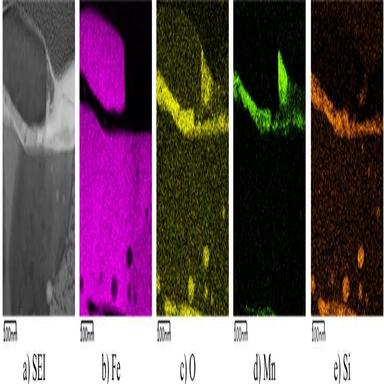
TEM EDS elemental mapping of the oxidized-reduced sample for area 1 in. a) SEI, b) Fe, c) O, d) Mn, e) Si.